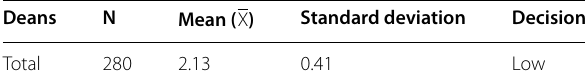
(awareness and practice) of non-violent discipline